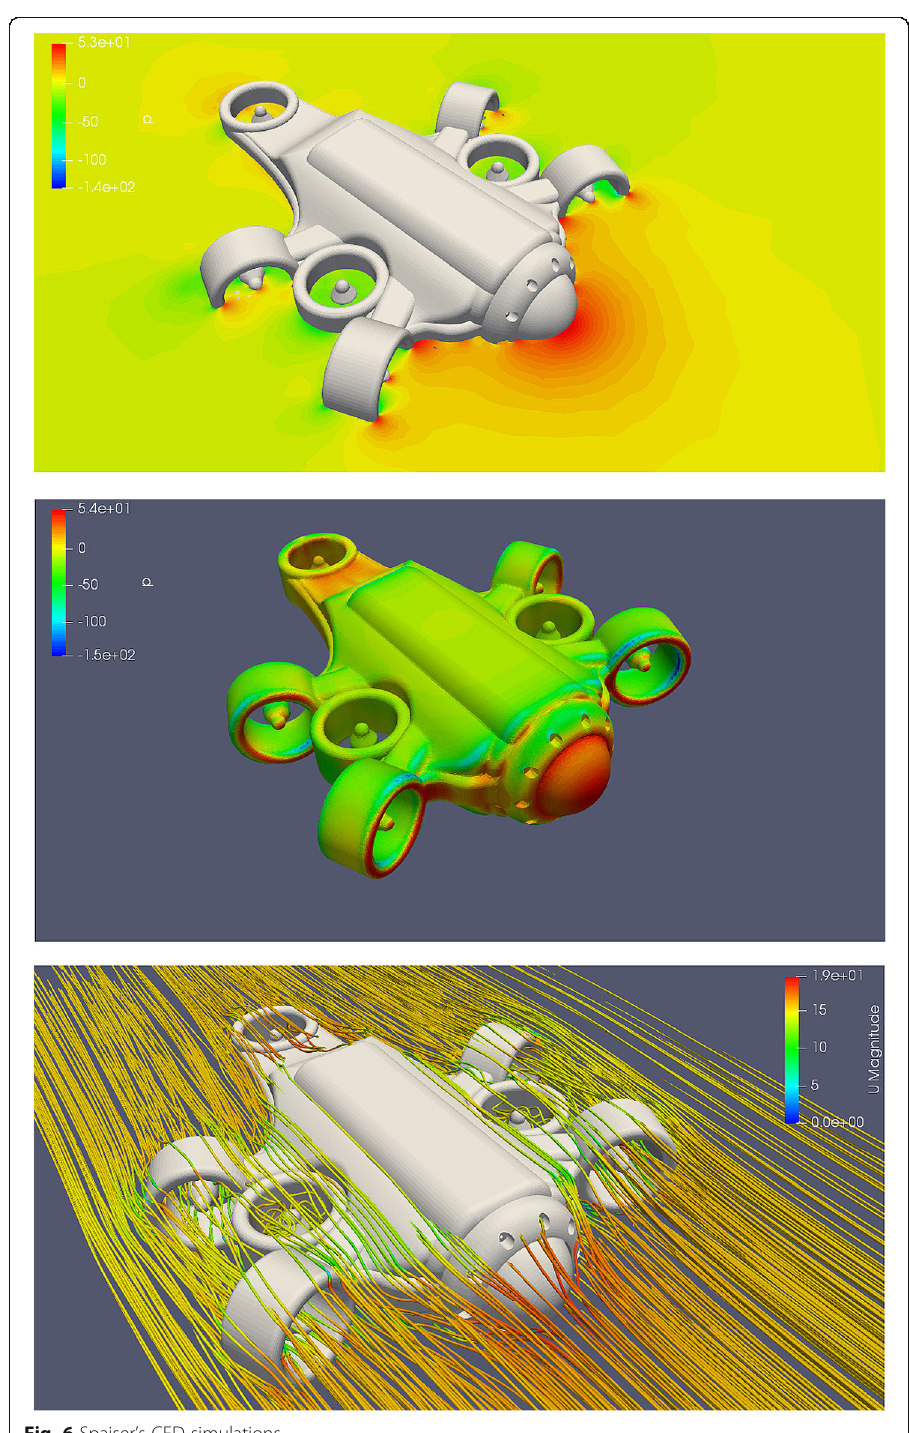
Fig. 6 Spaiser ’ s CFD